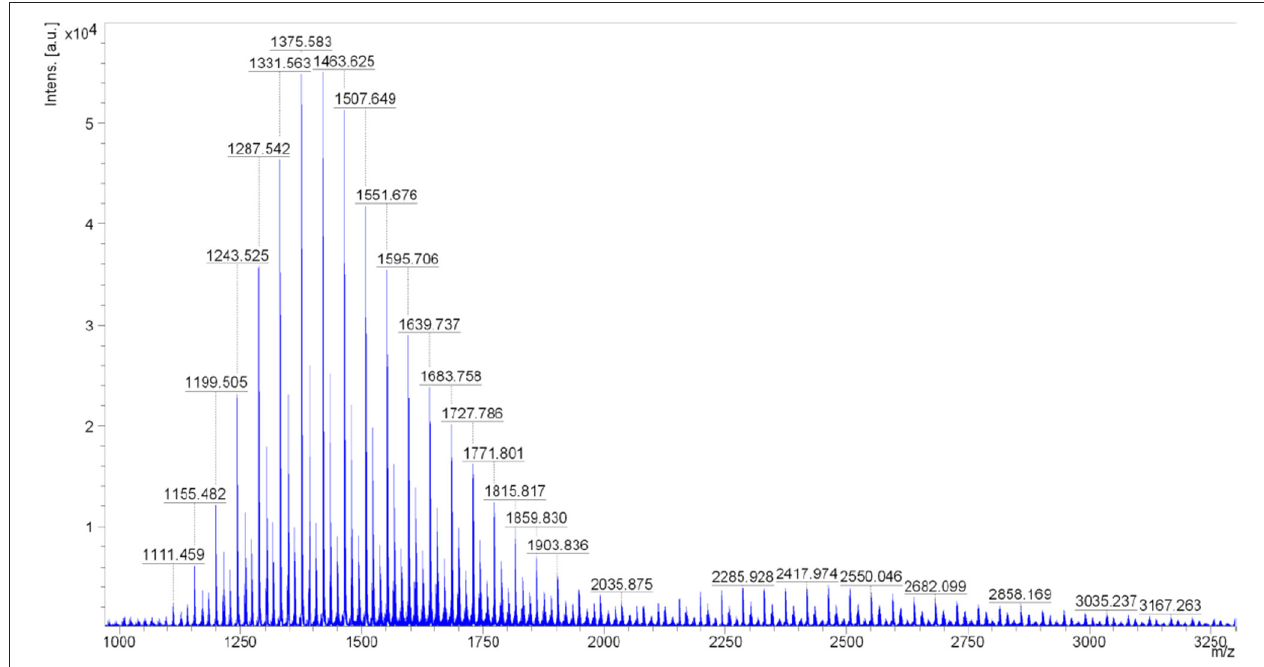
FIGURE 4 | MALDI-TOF spectrum of the RME sample (N AV = 70) obtained with the IAA matrix (range 1,000–3,200 Da).